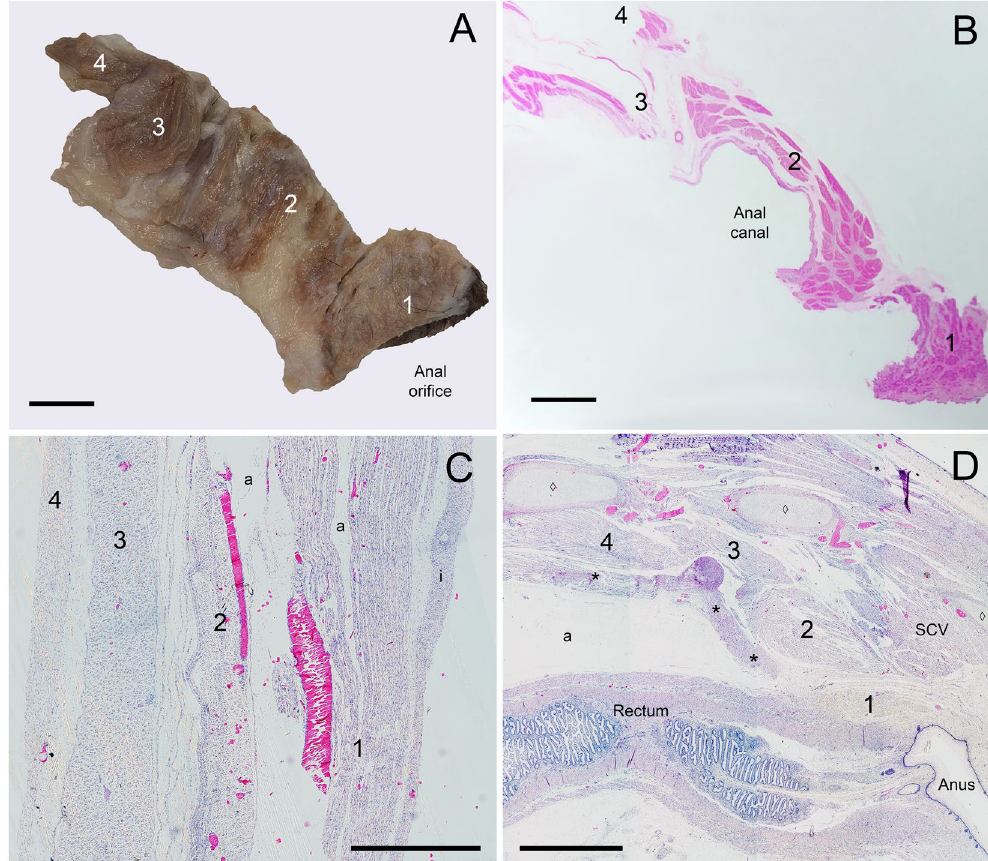
Figure 4. Perineum of an adult dog in ( A ) gross dissection (left lateral view, scale bar 5 mm) and ( B ) histological section (left lateral view, scale bar 5 mm). Histological sections of a fetal bovine aged 15 weeks of the ( C ) ventrolateral abdominal wall (left anterior view, scale bar 50 µ m) and ( D ) perineum (left lateral view, scale bar 2 mm). Structures labeled 1–4 are 1, subcutaneous layer; 2, external layer; 3, internal layer; and 4, transversus layer. Perineal muscle fibers ( B and D ) of the subcutaneous layer (1) are shown in cross- section, fiber orientation in the internal and external layers (2 and 3) is oblique, and fiber orientation in the transversus layer (4) is longitudinal in the taxa that have an anus that is shifted to protrude posteriorly, such as the bovine, dog, and horse, but is transverse in other taxa. The fetal muscle layers ( D ) are closely associated with smooth muscle of the internal anal sphincter and rectum ( * ) and developing sacral vertebrae ( ◊ ). a, artifact; i, integument; SCV, M. sacrocaudalis ventralis , a muscle that acts on the